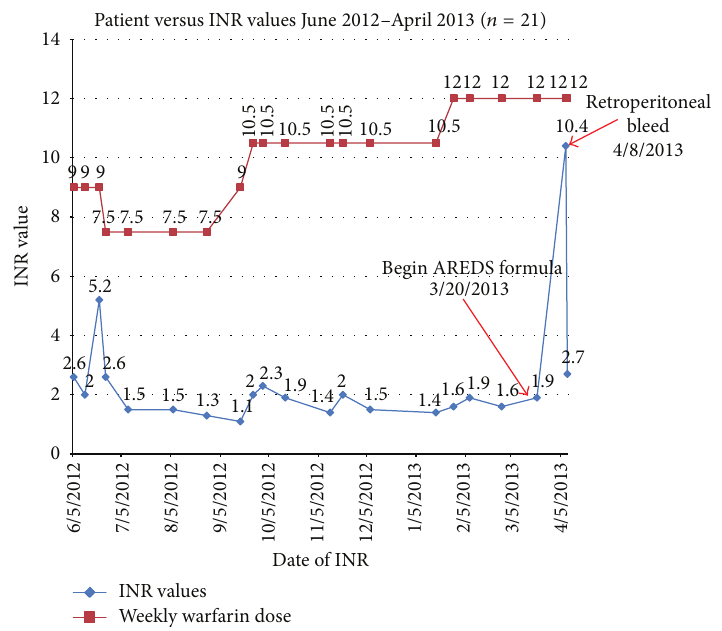
Figure 1: Timeline showing the patient’s weekly warfarin dose (mgs), INR results, and